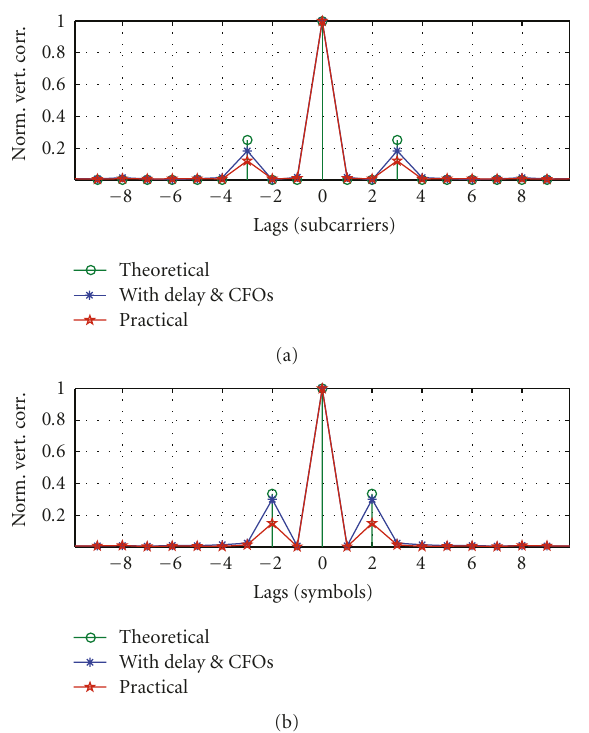
Figure 3: Normalized autocorrelations obtained utilizing a 60- symbol long signal (with FFT size 512) for a block size of 4 × 3 at 30 dB SNR in an AWGN channel. (a) Vertical autocorrelation. (b) Horizontal